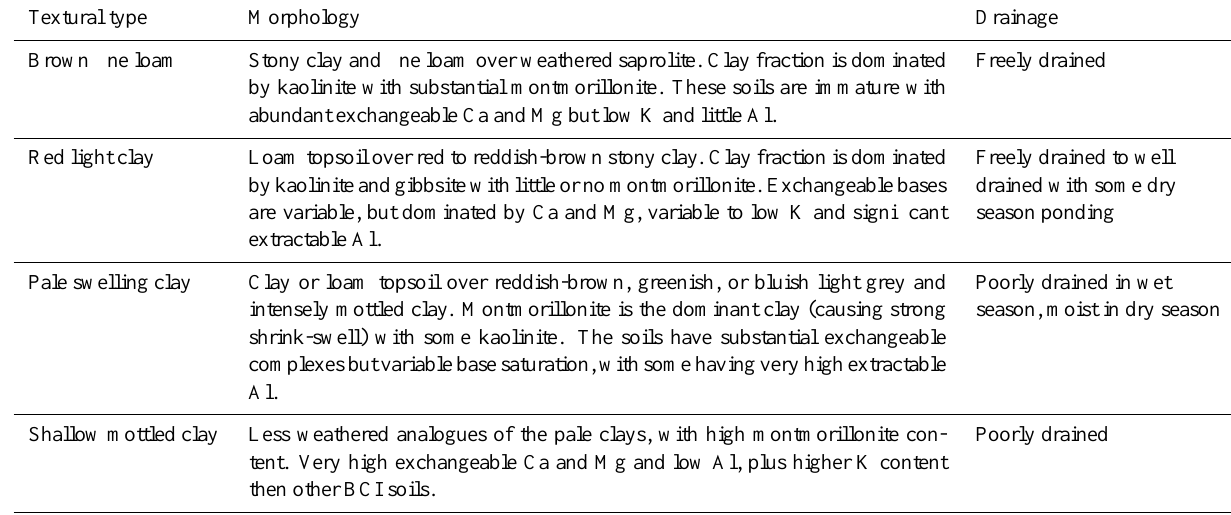
Table 2. Soil textural types as delineated during a local soil survey by Ballie et al. (2006). Textural types are also mapped in Fig. 1c. Textural type by kaolinite with substantial montmorillonite. These soils are immature with abundant exchangeable Ca and Mg but low K and little Al. by kaolinite and gibbsite with little or no montmorillonite. Exchangeable bases are variable, but dominated by Ca and Mg, variable to low K and significant extractable